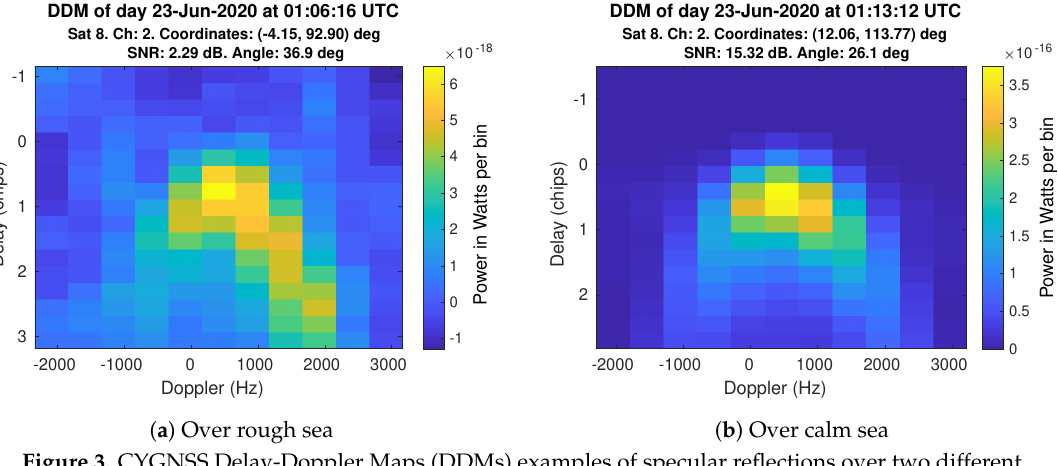
Figure 3. CYGNSS Delay-Doppler Maps (DDMs) examples of specular reflections over two different surfaces: ( a ) rough sea surface and ( b ) calm sea surface. Plots represent the equivalent analog power in Watts received per each delay/Doppler bin, distributed around the adjusted zero delay/Doppler for the particular geometry configuration. Note the difference in the color scale.